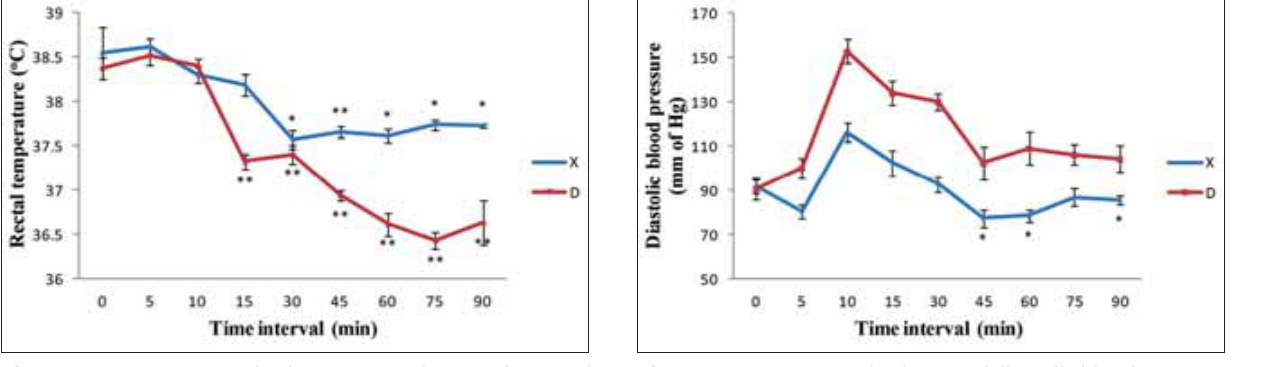
Figure-7: Mean±Standard error values of rectal temperature in animals of different groups. *Significantly different from the base value (p<0.05). **Significantly different from the base value (p<0.01).